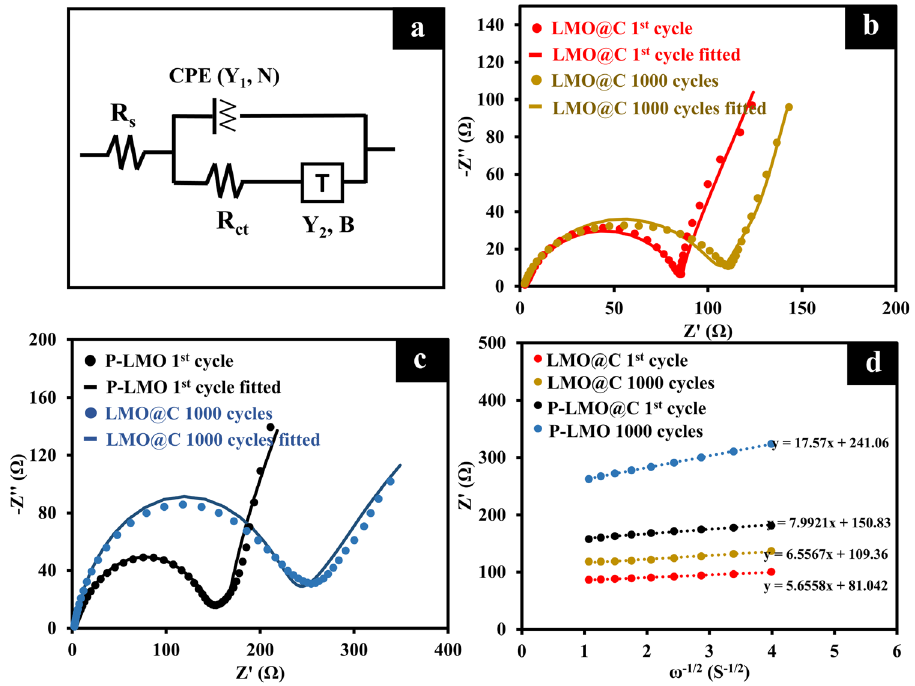
Fig. 7 Impedance measurement of half-cell P-LMO and LMO@C representing the cathode degradation after cycling. a The fi tted equivalent circuit. b – c EIS curves and fi tted curves in the half-cell CR2032 of ( b ) LMO@C, and ( c ) P-LMO before and after cycling. d The plot between Z ’ and ω -1/2 at low- frequency region for P-LMO and